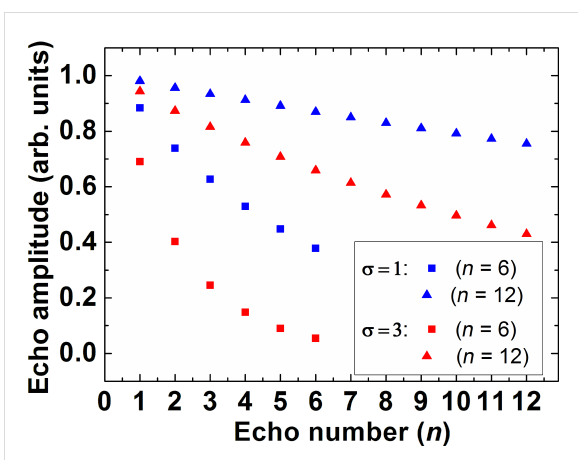
Figure 11: The calculated decay of the echo signal in the CPMG ex- periment as a function of the number n of the π -pulses in the CPMG protocol. The results of the modeling are presented for the same values of the dispersion σ as in Figure 10, σ = 1 (blue symbols) and σ = 3 (red symbols). The calculations were made for n = 6 (squares) and n = 12 (triangles). The total observation time of 10 τ c is the same as in Figure